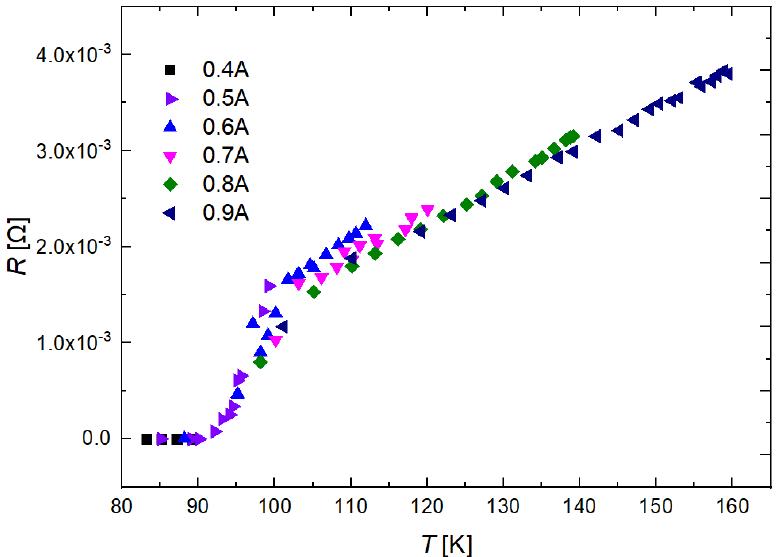
Figure 14. Relationship between the measured resistance and the temperature of the PCS at vari- ous